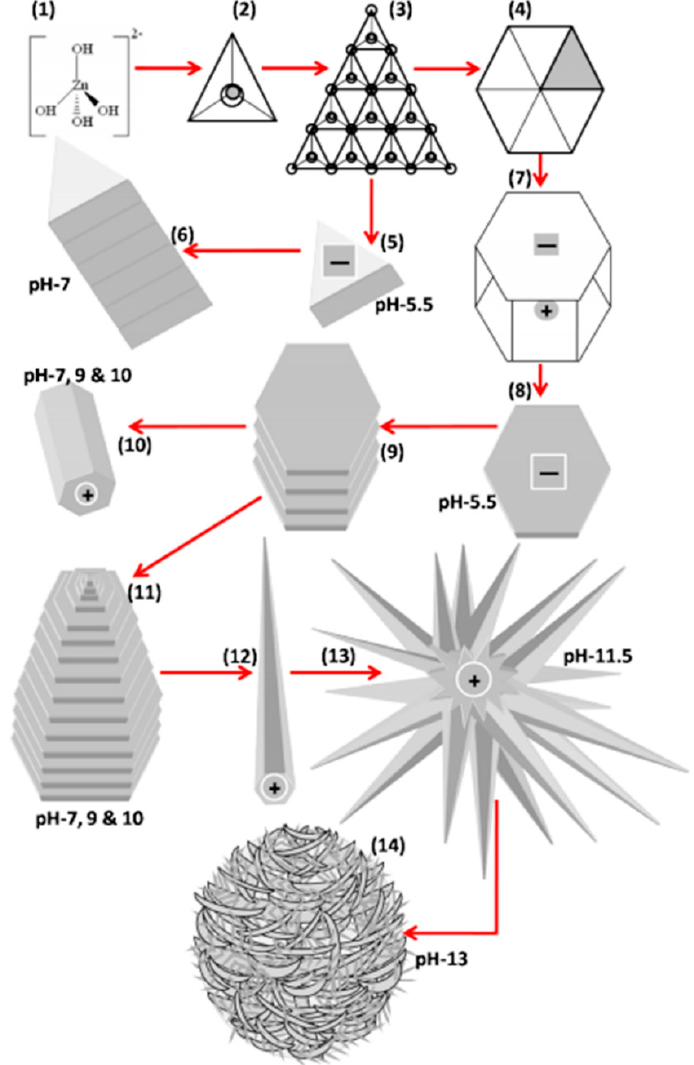
Figure 3. Schematic diagram of the growth mechanism of ZnO under coprecipitation route with varying the pH (5.5, 7, 9, 10, 11.5, and 13.0) of solution during synthesis.